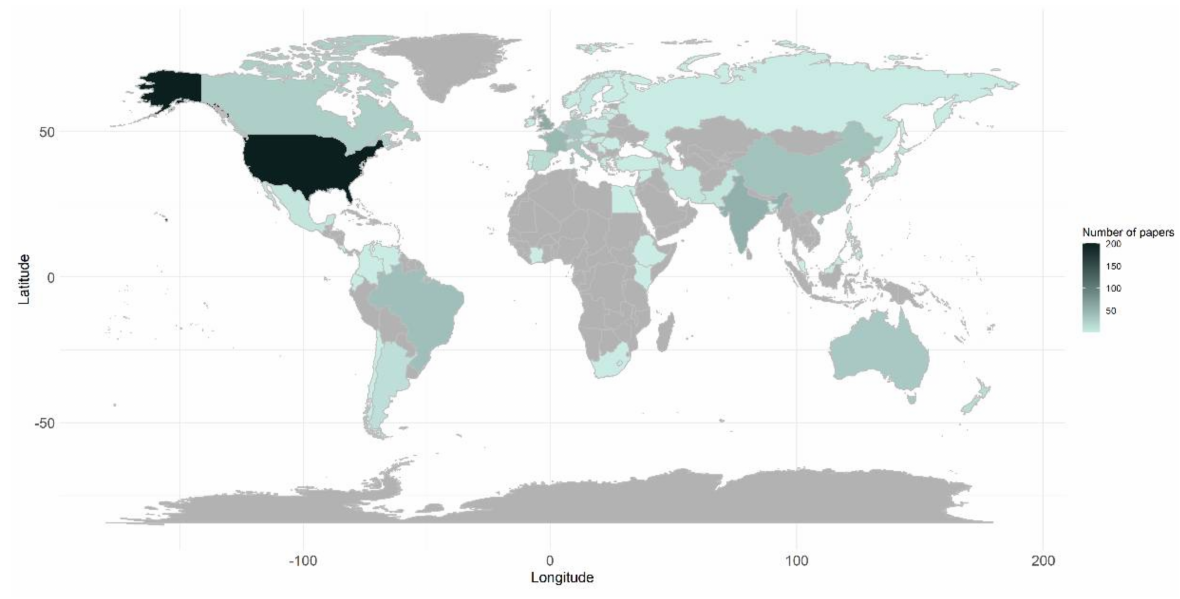
Figure 3. Country of origin of the studies. The total number of papers per country is shown as a color gradient, from light green-blue (lower number of papers) to dark green-blue (higher number of papers). Countries for which no corresponding authors have been found in the literature are indicated by